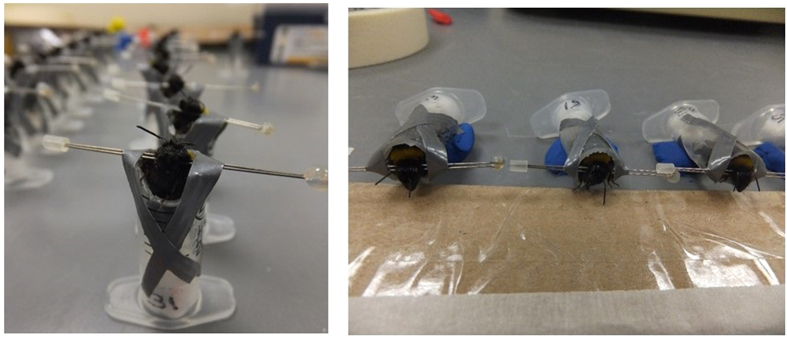
Harnessed bees prior to PER testing (a) and in horizontal positions after feeding in the acute experiment (b).Bee harnesses were held in place with a piece of modelling clay (blue plasticine) and their head set above a piece of plastic covered cardboard (used for easy disposal the next day to prevent cross treatment contamination) on which sucrose solution was presented (photos by DAS). For additional details about the harnessing methodology see Smith & Raine37.